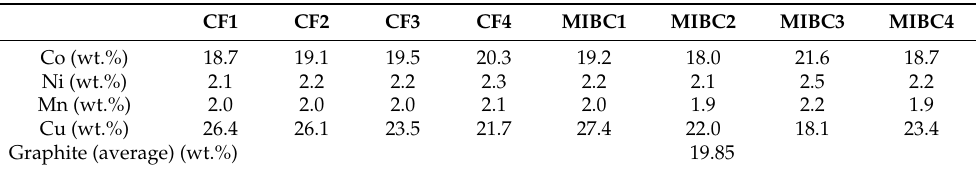
Table 4. The experiment-specific head grades for Co, Ni, Mn, and Cu, and the average head grade of graphite in the froth flotation experiments.